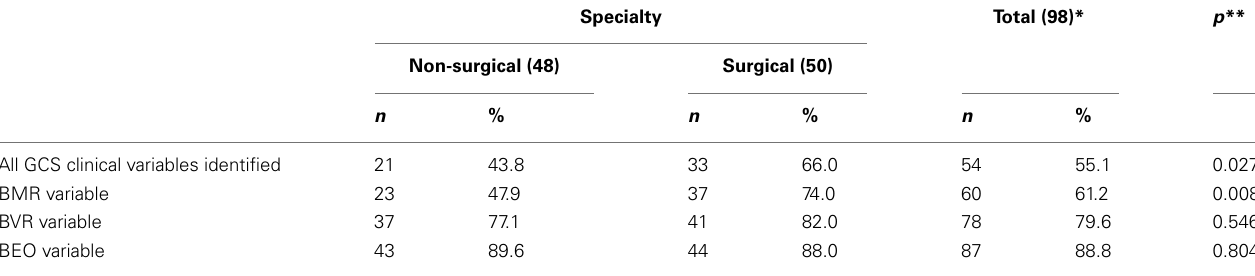
Table 2 | Comparison between surgical and non-surgical specialties of the participants who correctly identified the clinical variables of GCS.